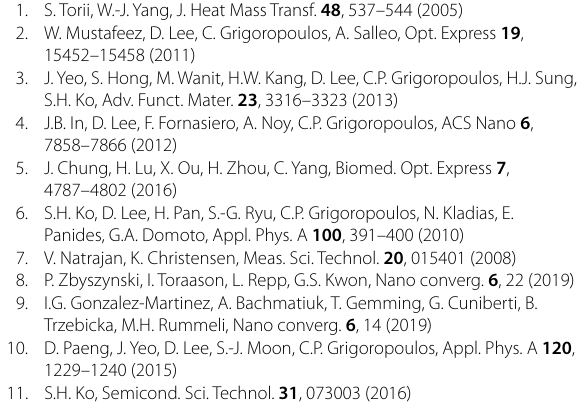
ρ resistivity, R s sheet resistance, R resistance, ns nanosecond, cw continuous-wave, ps picosecond, fs femtosecond